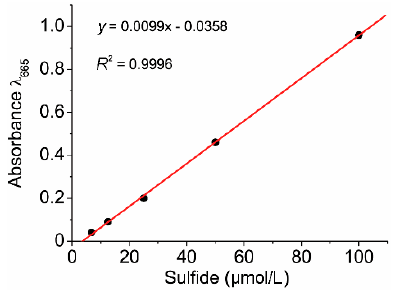
Figure 1. The calibration used for the determination of sulfide concentrations.